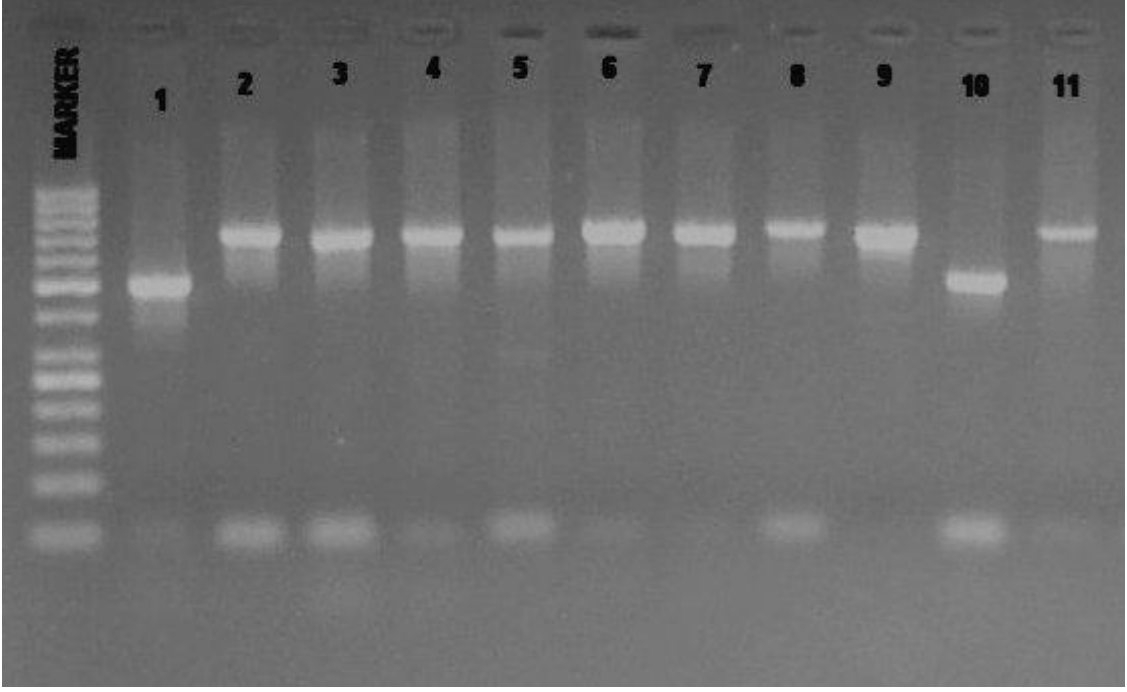
Figure S1. PCR amplified fragments: 1. TLR6_1; 2. TLR6_2; 3. TLR6_3; 4. TLR6_4;